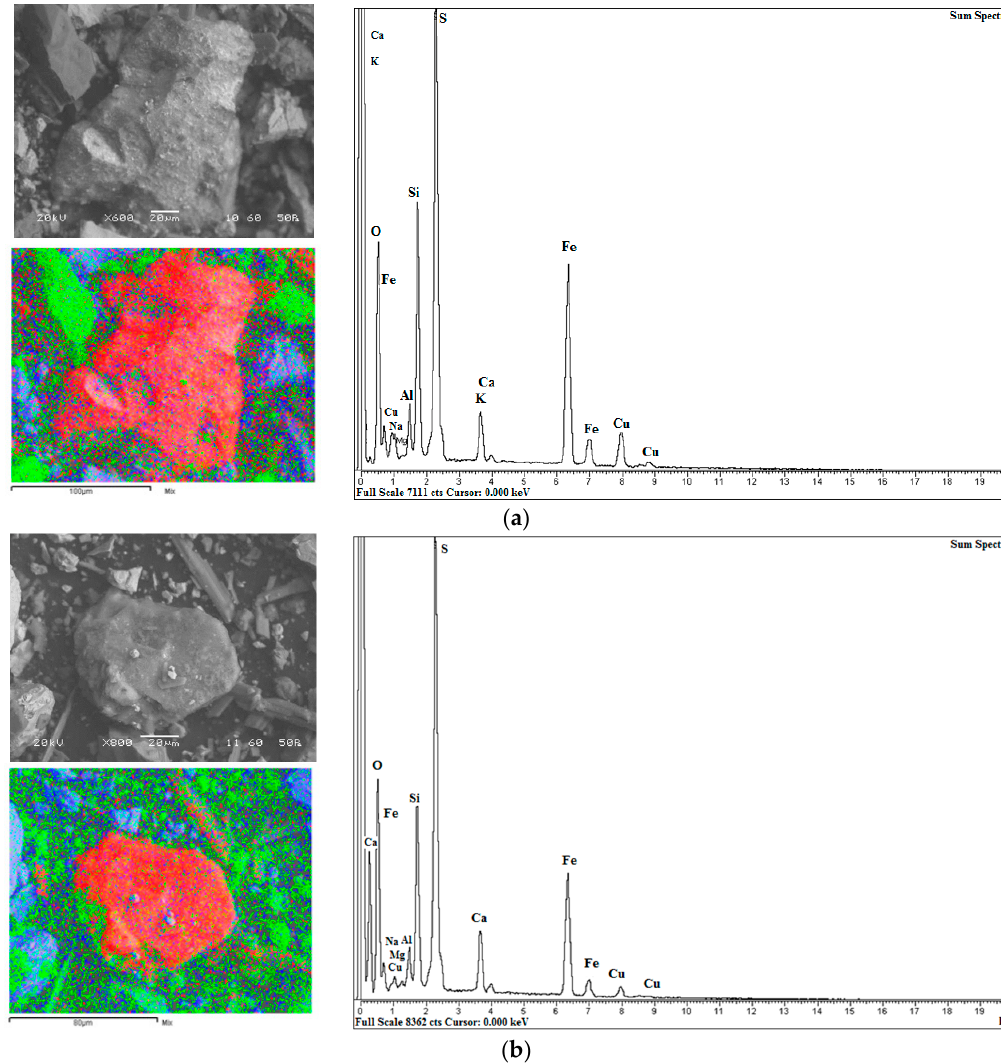
Figure 10. Results of scanning electron microscopy (SEM) analysis carried out using the solid residue. The ore sample was leached in: ( a ) seawater medium and ( b ) water medium. The false red color shows the sulfur presence.